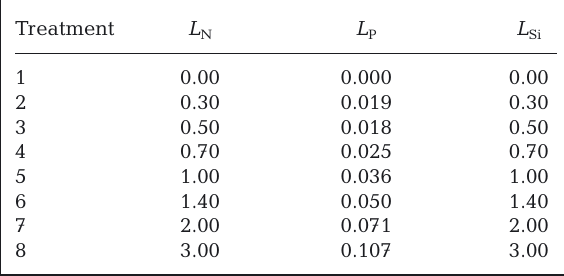
l −1 d −1 (Table 1) to a molar N:Si ratio of 1. We used this ratio of Si to allow diatoms to dominate the experi-